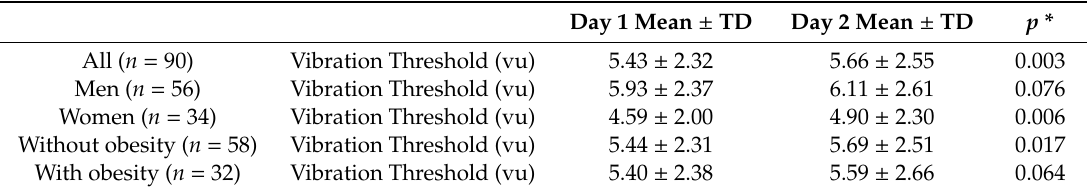
Table 2. Vibration units in the Vibratron 2.0 test to measure the vibration perception threshold in 2 measurements with an interval of 7 d.